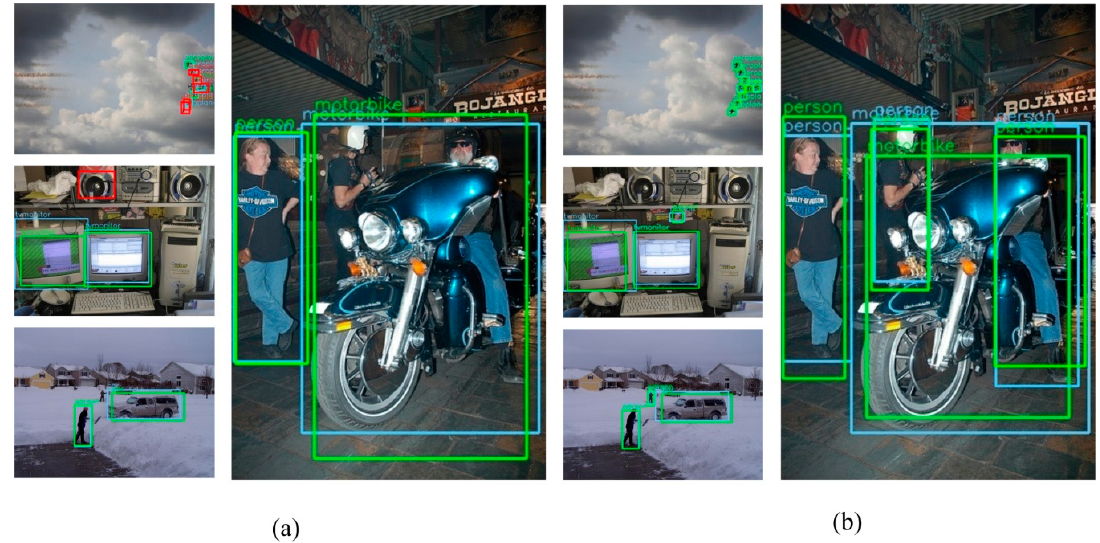
Figure 10. Comparison of each network on the PASCAL VOC dataset. ( a ) YOLO V3; ( b ) Improved YOLO V3.